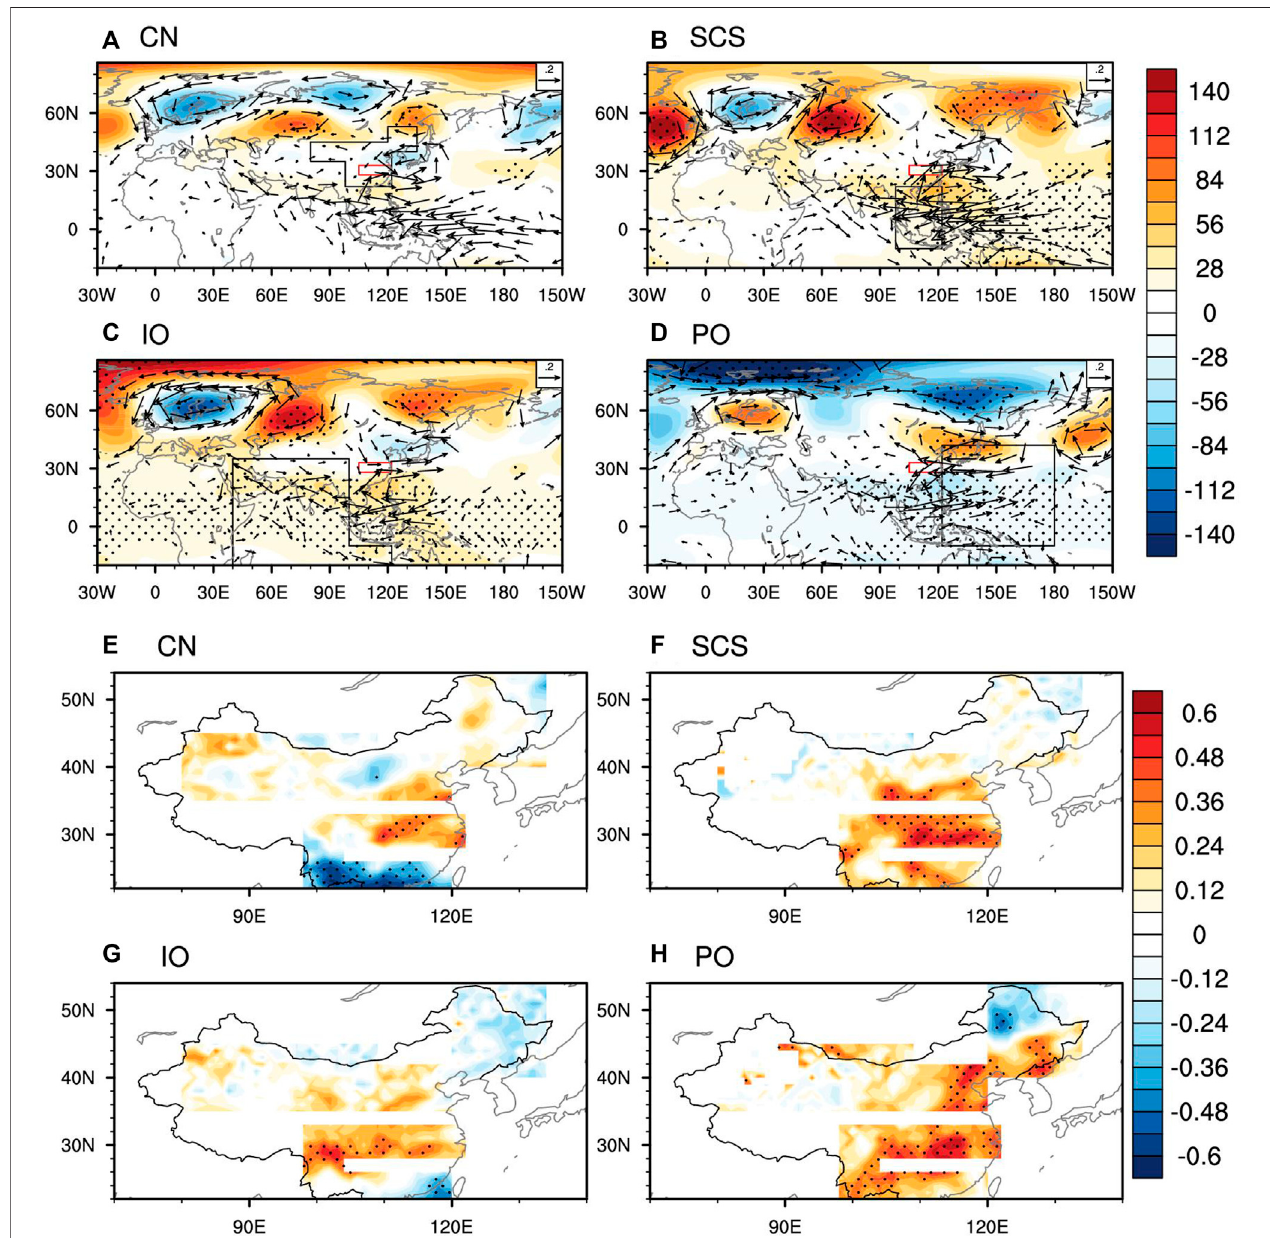
FIGURE 8 | As in Figure 5 but for the YRV. Panels (A – D) show circulation anomalies regressed against the CN, SCS, IO and PO moisture sources. Panels (E – H) show the CN, SCS and IO source precipitation anomalies correlated with the WNPSH index, and the PO source with the PJ index.